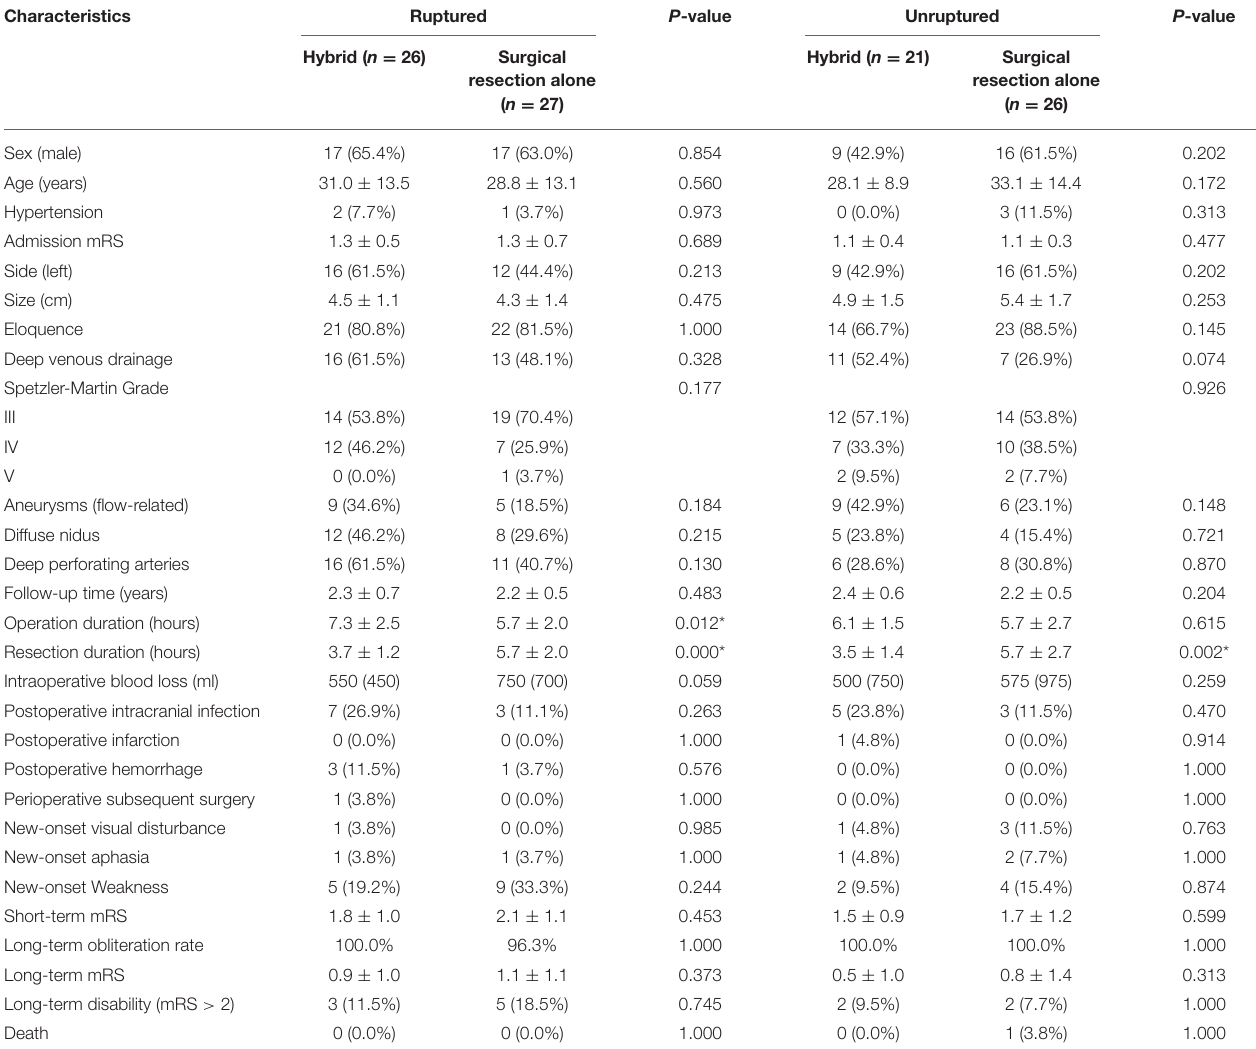
TABLE 2 | Comparison of clinical outcomes between hybrid group and surgical resection alone group in ruptured AVMs and unruptured AVMs.